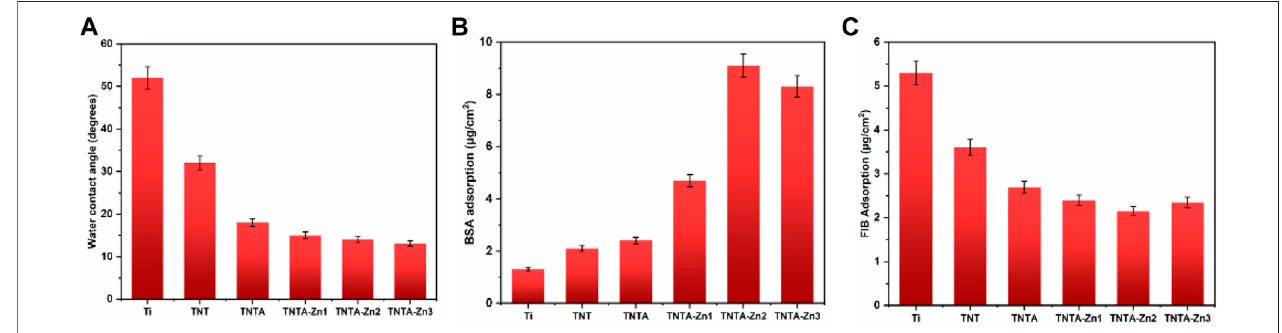
FIGURE 4 | Water contact angles (A) , BSA adsorption (B) , and FIB adsorption (C) of the different samples. Three parallel samples were measured, and the values were averaged and are expressed as mean ± SD (standard